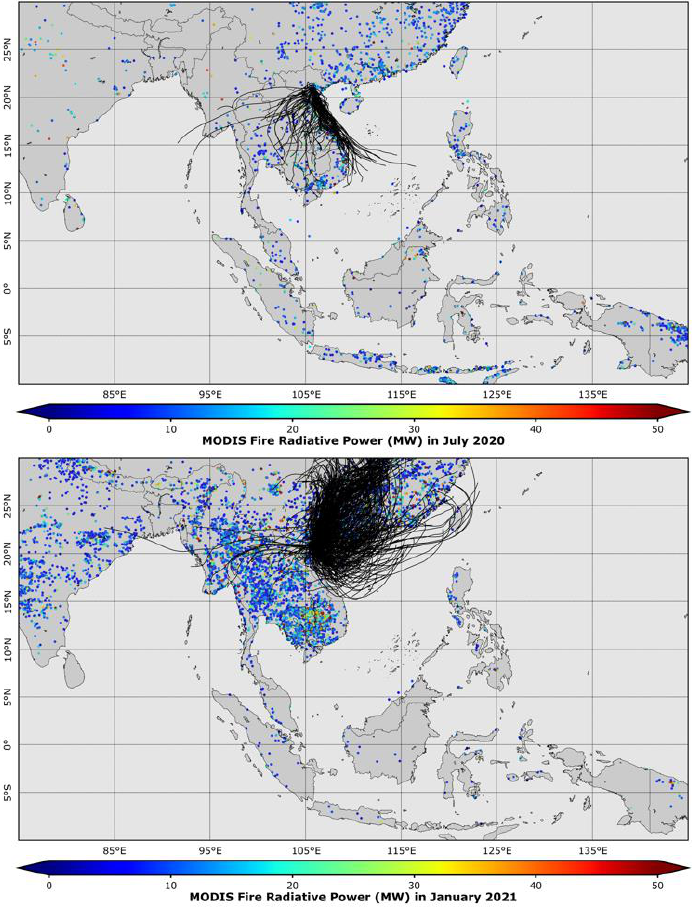
Figure 7. MODIS cumulative fire radiative power over the Southeast Asian region and three-day air mass backward trajectories (indicated by the black curves) arrived at the sampling site in Hanoi during the summer period (July 2020) and winter period (January 2021).